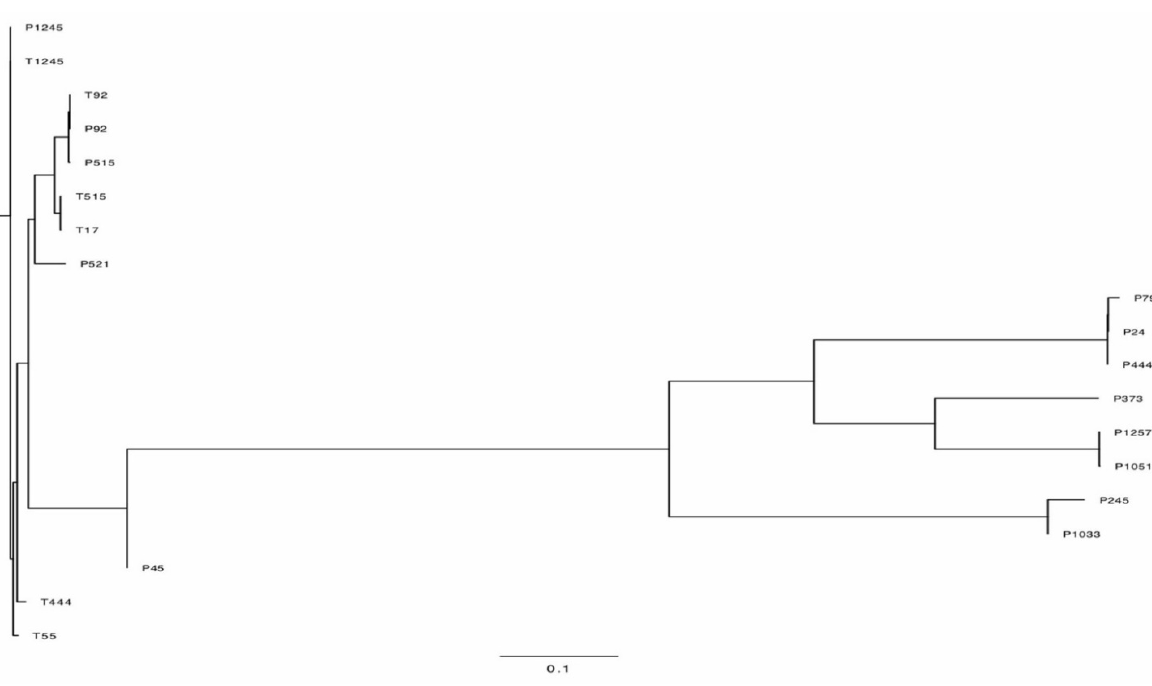
Figure 7. Phylogenetic tree showing the relatedness of phages used in this study.